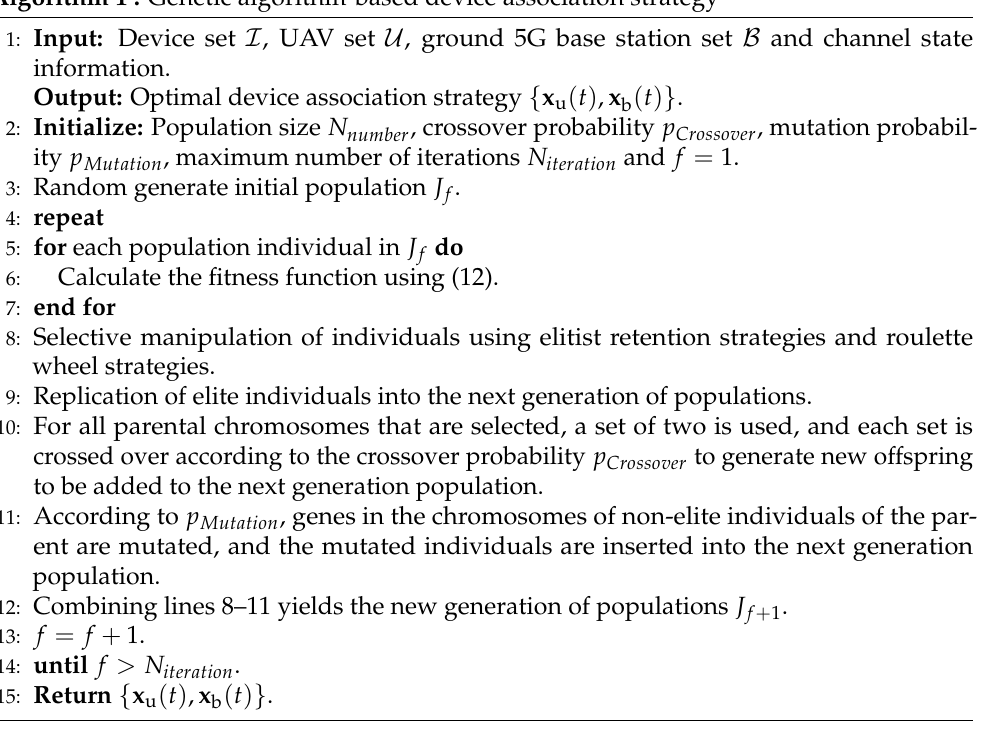
Algorithm 1 : Genetic algorithm-based device association